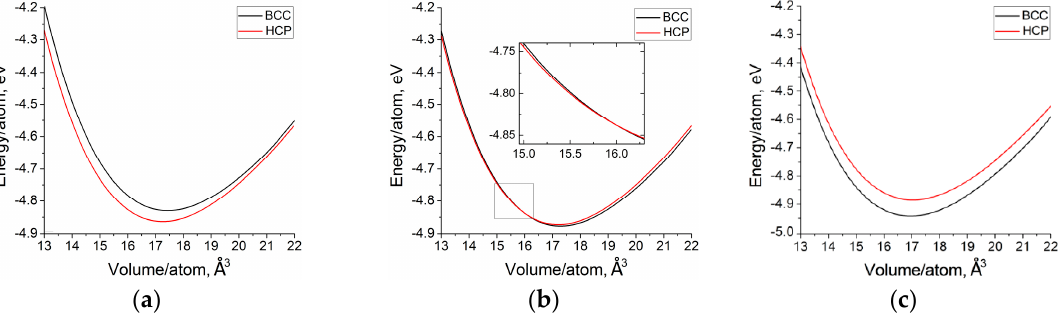
Figure 11. Energy per atom in the β -Ti inclusions with 5 ( a ), 13 ( b ) and 19 at. % of vanadium ( c ) as a function of atomic volume.